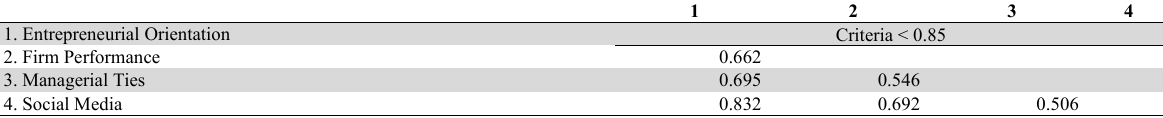
Heterotrait-Monotrait Ratio (HTMT)